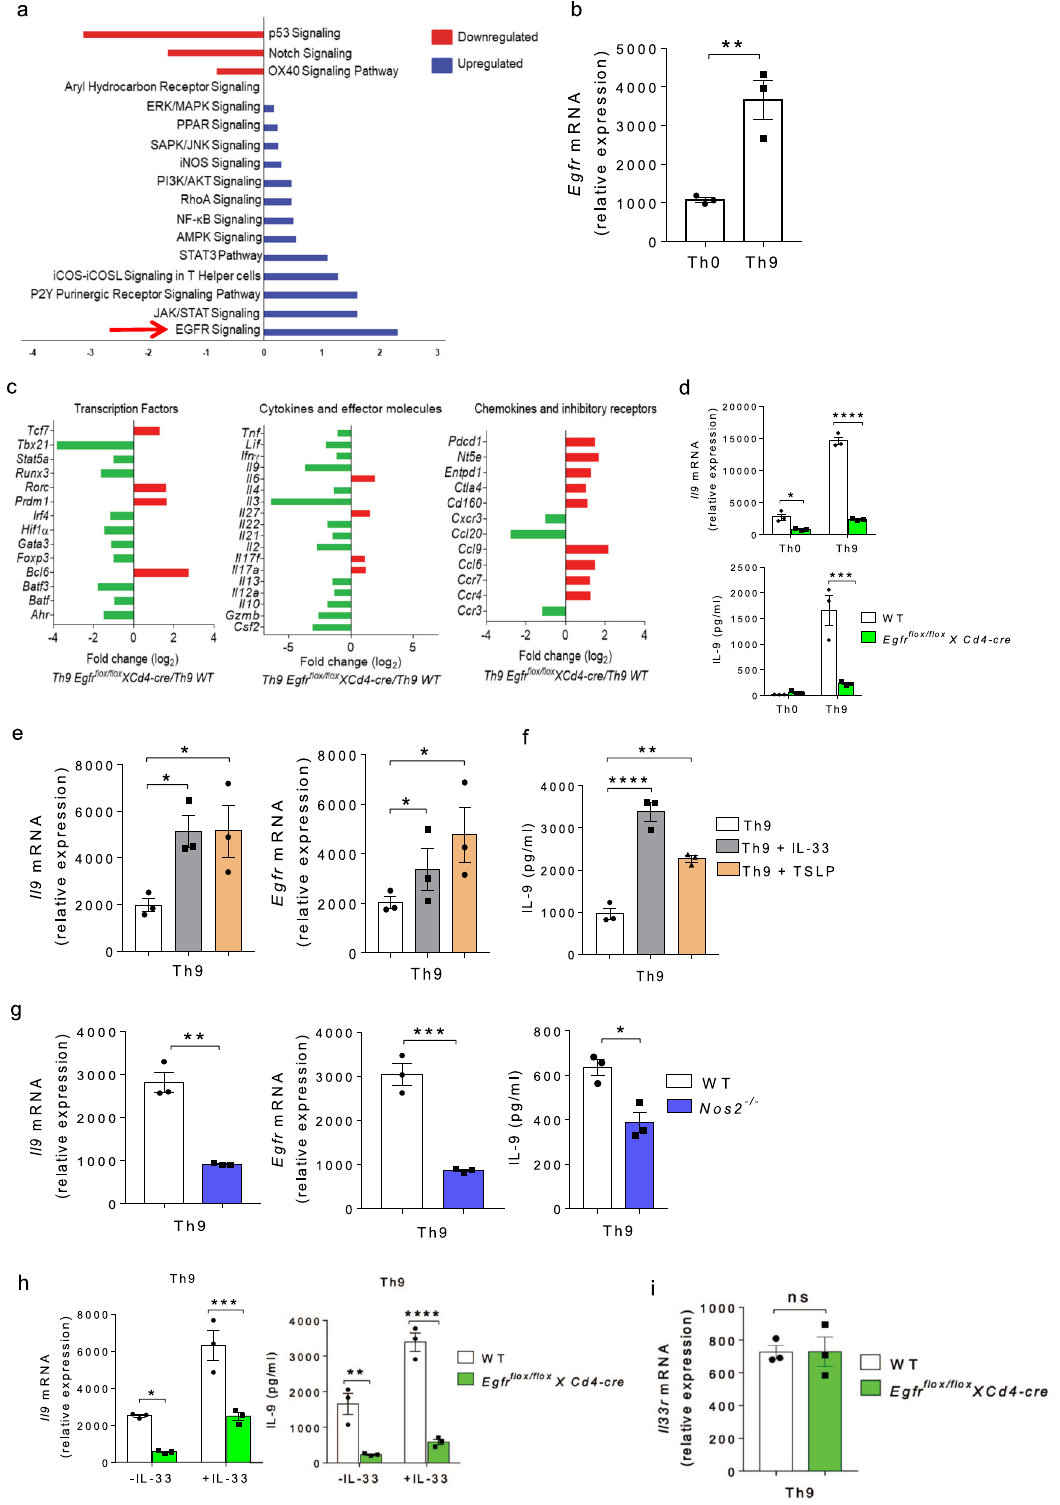
test the in vivo effect of EGFR inhibition, naïve CD4 + T cells from OT-II TCR transgenic mice were in vitro polarized into Th9 cells in the presence or absence of ge fi tinib. These cells were then adoptively transferred into a B16-OVA tumor-bearing WT mice and the tumor progression was monitored. Th9 cells signi fi cantly